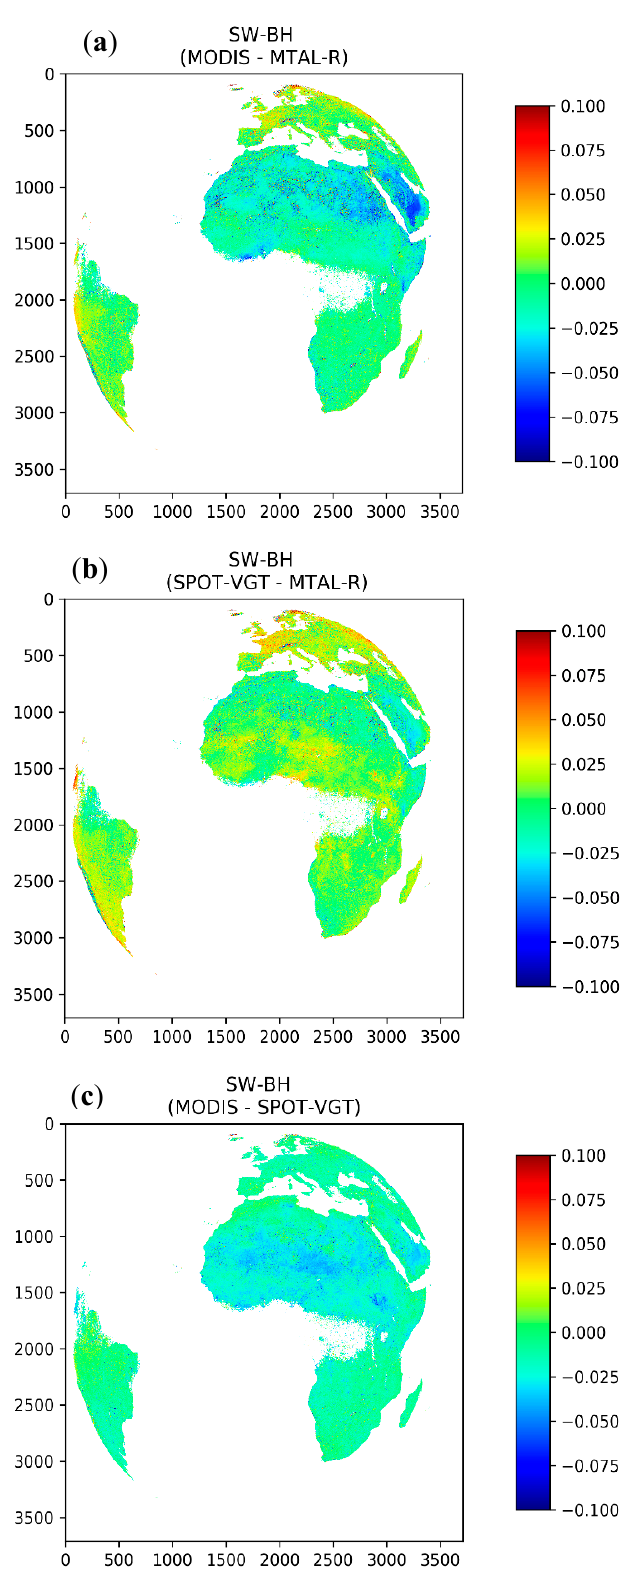
Figure 9. Spatial maps of the mean bias observed the year 2012 between the satellite-based product pairs, ( a ) MODIS and MTAL-R; ( b ) SPOT-VGT and MTAL-R and ( c ) MODIS and SPOT-VGT. It is clear from Figure 9 that MTAL-R is negatively biased over Europe, compared to MODIS and SPOT-VGT, whereas it is positively biased over Northern Africa and the Arabic peninsula.